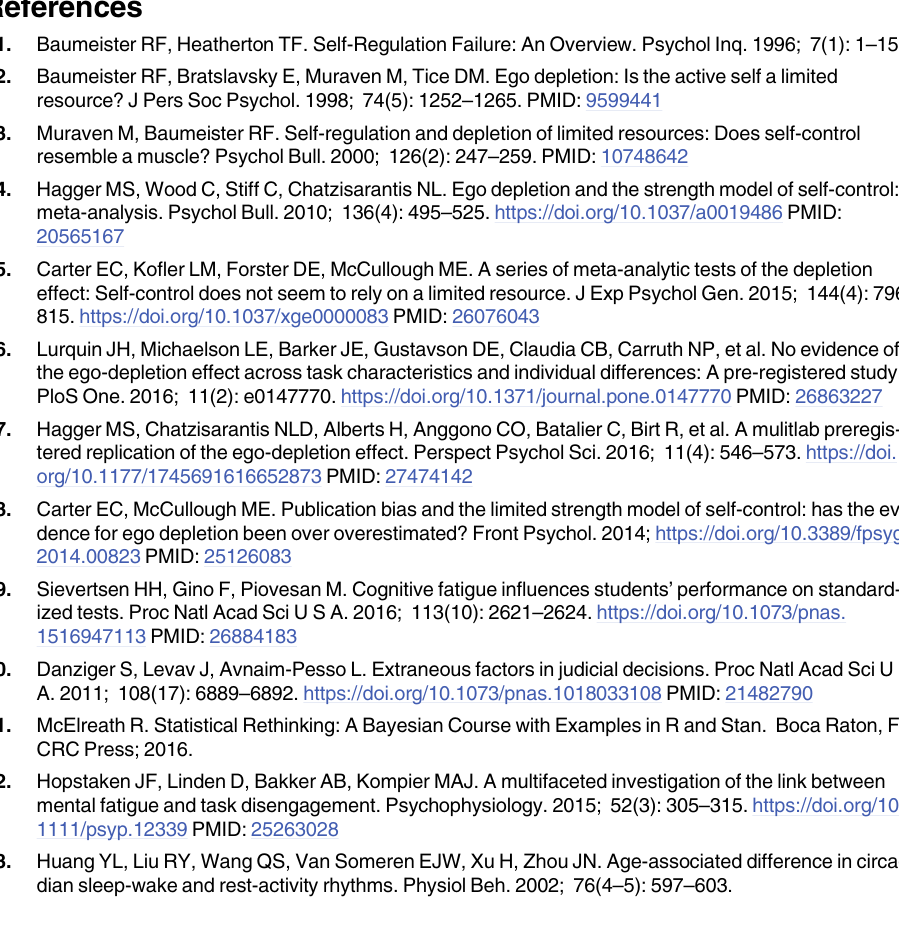
S9 Table. Accuracy as a function of trial for samples 1 and 2 –Nested within session within